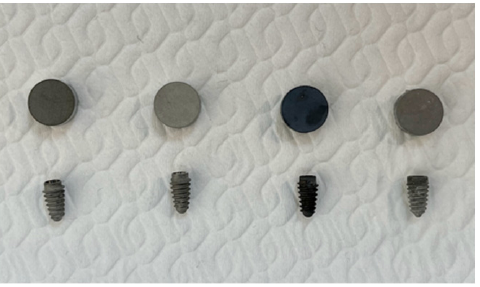
Figure 1. Manufactured disks and implants of the experimental surface groups. Table 1. Surface modifications of disks.